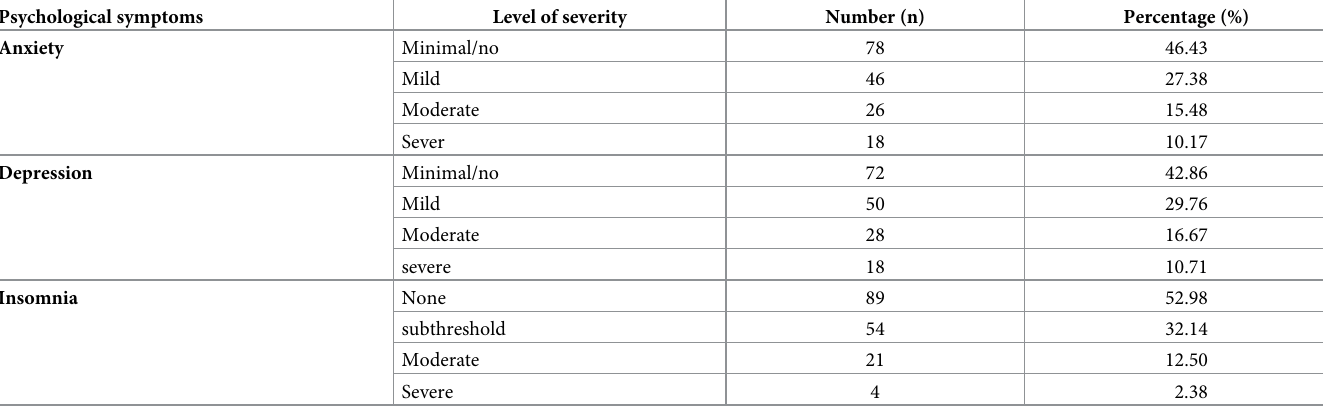
When comparing the three symptoms among individuals with varying genders, ages, and lev- els of work experience, the results only demonstrated a significant difference in depression with working experience and age (Table 5). Post-hoc analysis comparison showed that depres- sion was lower in individuals older than 35 years old compared to those between those between 20 to 25 years old with a mean difference of 4.6 (1.60–7.61). The same pattern was found for depression among those individuals with different levels of work experience. Those Table 3. Severity level of anxiety, depression, and insomnia among radiology staff. Psychological symptoms